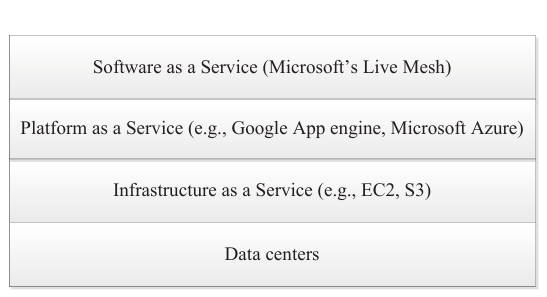
Figure 2. Service-oriented cloud computing